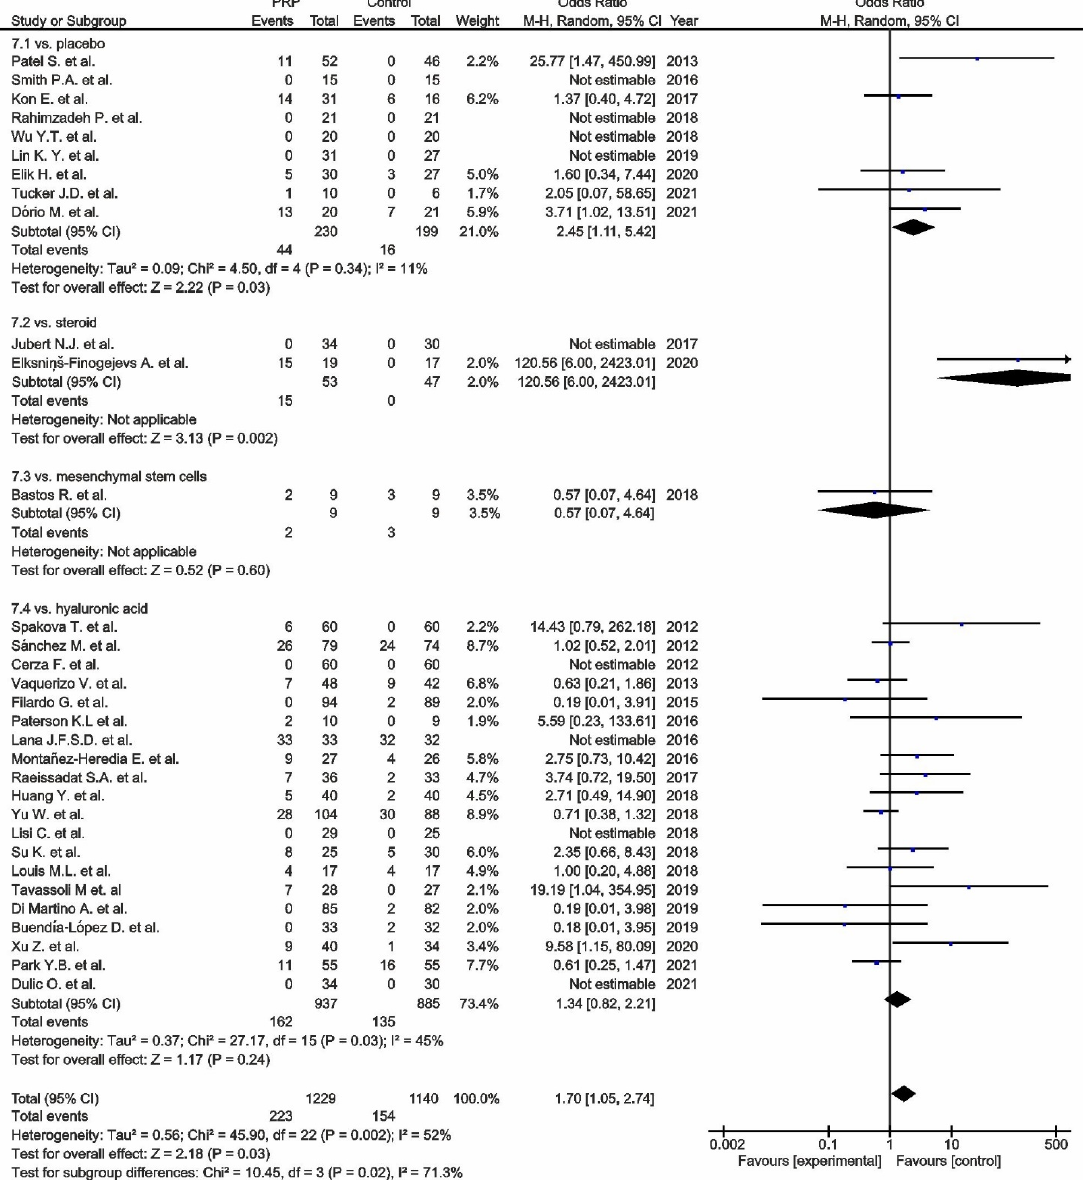
Figure 6. Forest plot for KOOS sub-scores (ADL, activities of daily living; CI, confidence interval; Figure 3. Forest plot for VAS scores comparing PRP versus control (CI, confidence interval; IV, in- Figure 7. Forest plot for adverse events (CI, confidence interval; M-H, Mantel-Heanszel; , odds IV, inverse variance; QoL, quality of life; SD, standard deviation; , mean with 95% confidence verse variance; SD, standard deviation; , mean with 95% confidence interval for total and sub- interval for total and subtotals; , mean with 95% confidence interval for source data ). , odds ratio with 95% confidence interval ratio with 95% confidence interval for total and subtotals; totals; , mean with 95% confidence interval for source data). for source